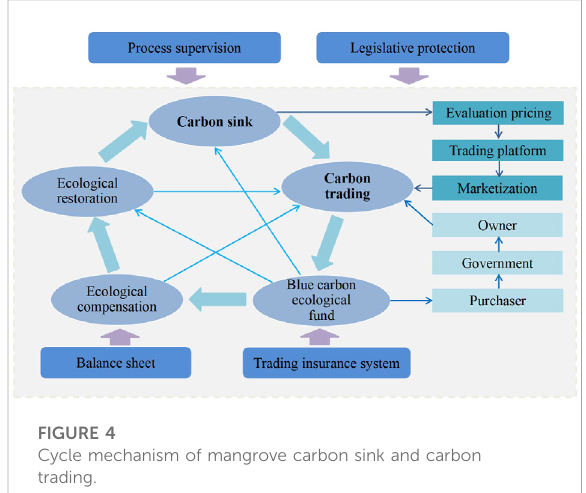
FIGURE 4 Cycle mechanism of mangrove carbon sink and carbon